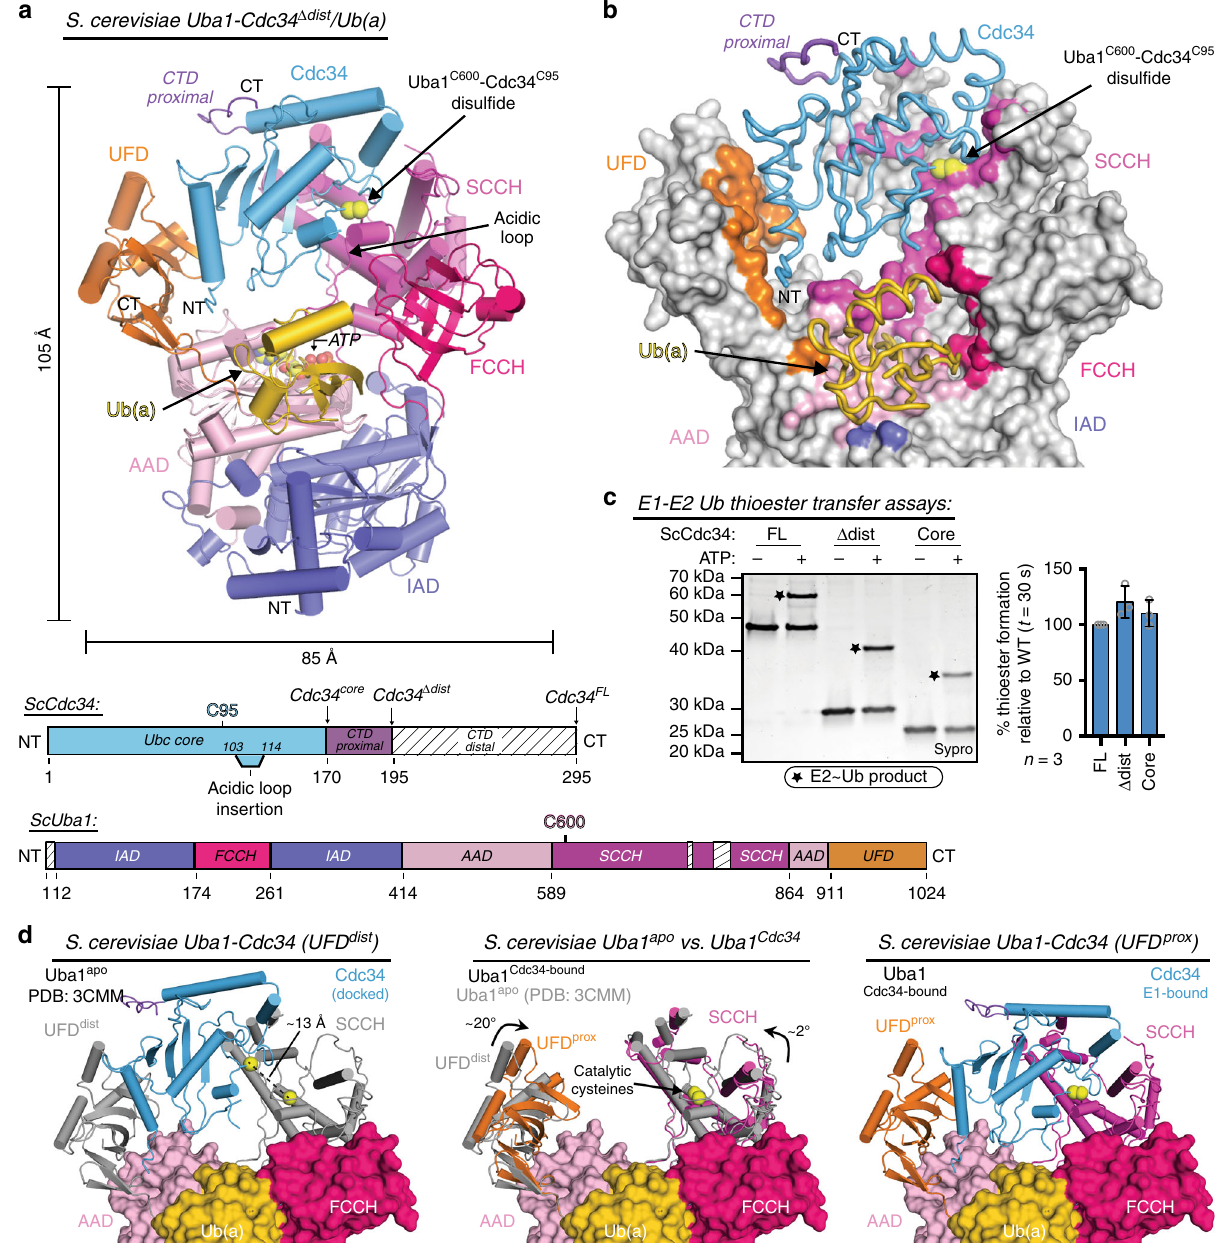
Fig. 1 Overall architecture of a ScUba1-Cdc34 Δ dist /Ub(a) complex. a Top , overall structure of S. cerevisiae Uba1 in complex with truncated S. cerevisiae Cdc34, Cdc34 Δ dist (blue), and ubiquitin adenylate, Ub(a) (gold), with Uba1 domains colored and labeled. Catalytic cysteines are indicated by yellow spheres. Bottom , schematic representations of the ScUba1 and ScCdc34 constructs with domains colored as above. b Uba1-Cdc34 structure with Uba1 surface representation in gray with only contacting residues colored. Cdc34 Δ dist and Ub(a) are represented as worms. c E1-E2 thioester transfer assays for Cdc34 variants with boundaries as indicated in schematic, and with normalized quanti fi cation of E2 thioester formed represented as mean ± SD with three independent replicates shown as gray circles, right . Stars indicate the E2~Ub thioester product. Source data are provided as a Source Data fi le. d Left , Cdc34 E1-bound modeled onto Uba1 apo UFD (gray) in open conformation (PDB:3CMM); distance between catalytic cysteines is indicated by a dashed line. middle , ScUba1 Cdc34-bound /Ub(a) as in a with ScUba1 apo /Ub(a) superimposed in gray. Arrows indicate rotation of the UFD and SCCH when bound to Cdc34. Right , ScUba1-Cdc34 Δ dist /Ub(a) complex structure colored as in